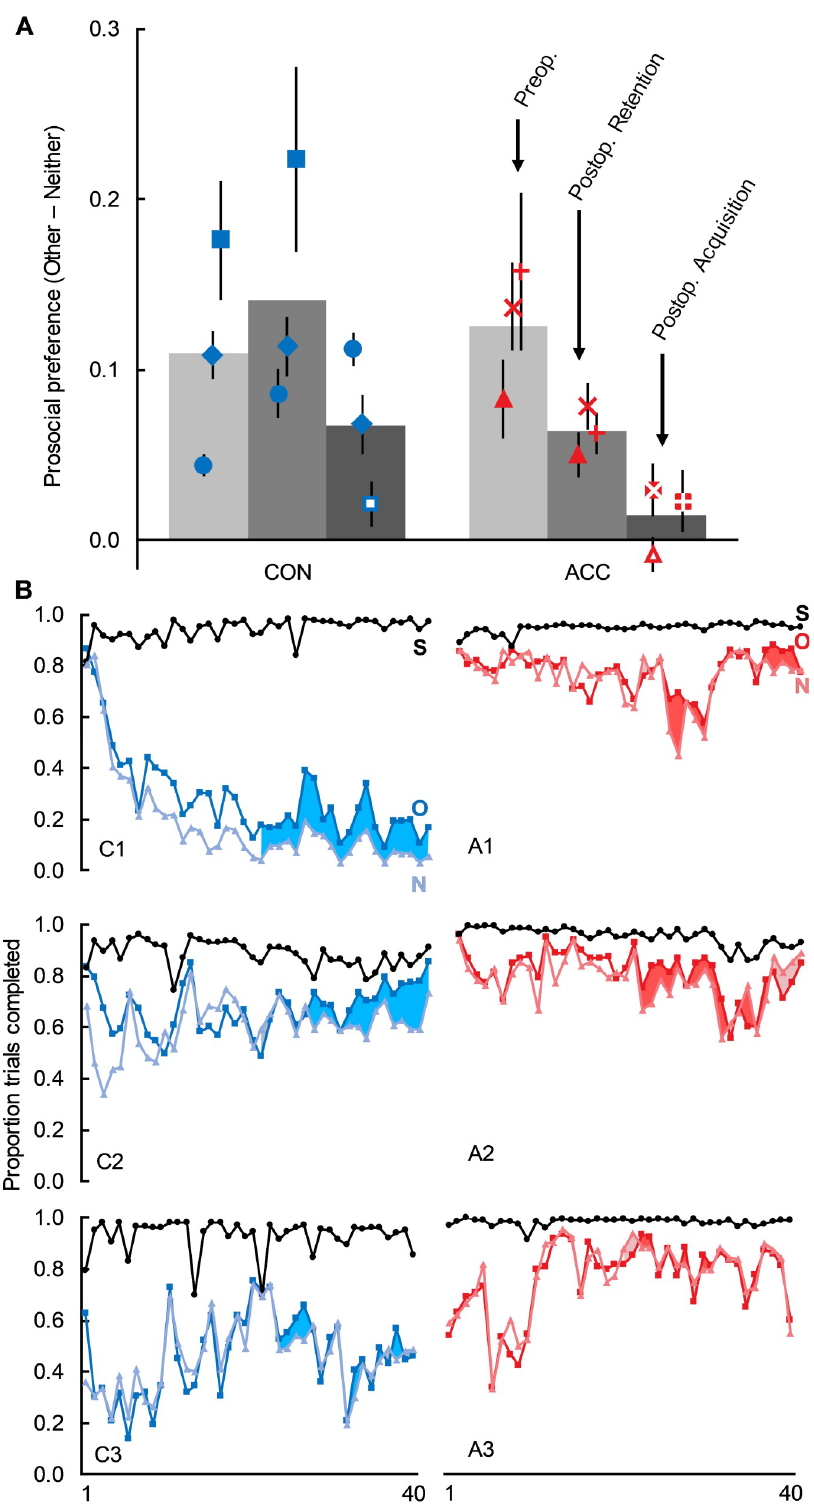
Fig 2. ACC damage reduced preoperatively learned social preferences and eliminated formation of postoperative social preferences. (A) Prosocial preference measured as the proportion of Other trials completed minus